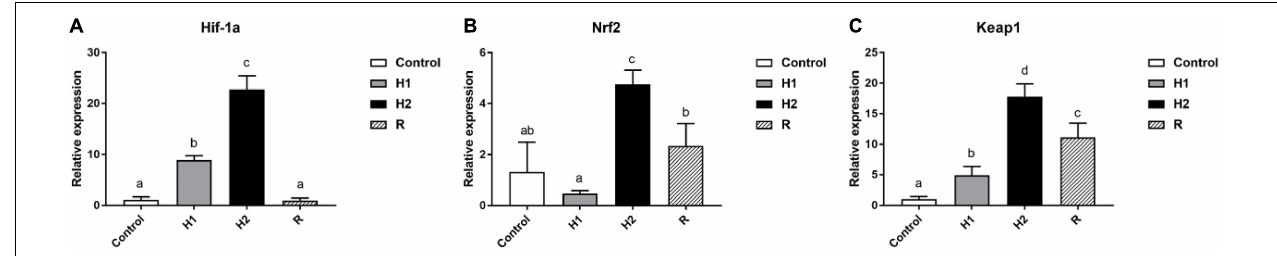
FIGURE 6 | Expression of oxygen sensor in the blood cell of largemouth bass after acute hypoxia and reoxygenation using qRT-PCR analysis. (A) HiF-1 alpha subunit (Hif-1 α ) expression. (B) Nuclear factor erythroid 2-related factor 2 (Nrf2) expression level. (C) The expression of Kelch-1ike ECH- associated protein l (Keap1). Different lowercase letters above each bar represent significant differences ( P < 0.05).